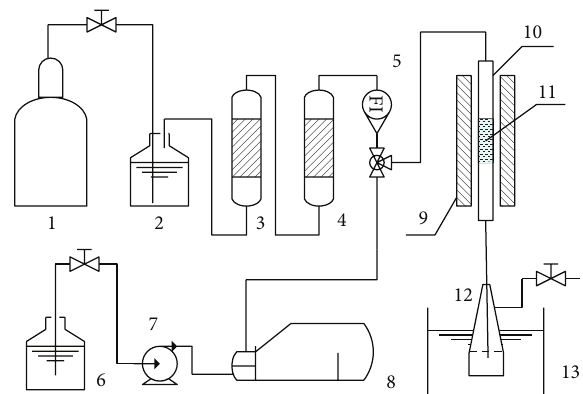
Figure 1: Schematic diagram of vinyl acetate synthesis. 1: acetylene gas; 2: 20% NaOH solution; 3: silica gel; 4: activated carbon; 5: gas flowmeter; 6: acetic acid; 7: dual piston metering pump; 8: gasifier; 9: heating device; 10: reaction tube; 11: catalyst layer; 12: collector; 13: ice-water